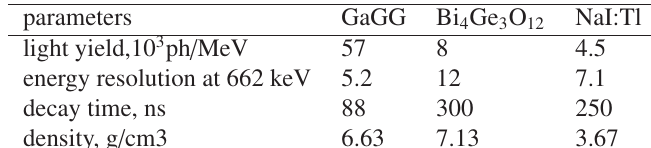
Figure 2. Scheme of the cell for “spaghetti” ECal and its assembly.